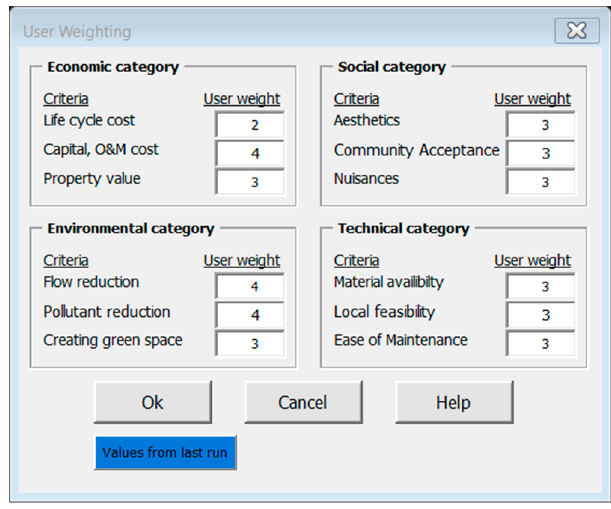
Figure 12. Default weights for different criteria in BMP selection module.